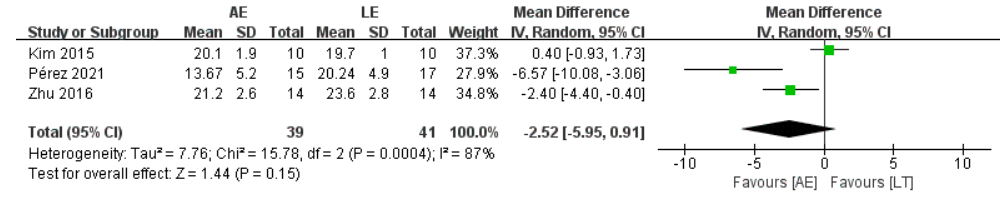
Figure 5. Forest plot: effects of TUGT.